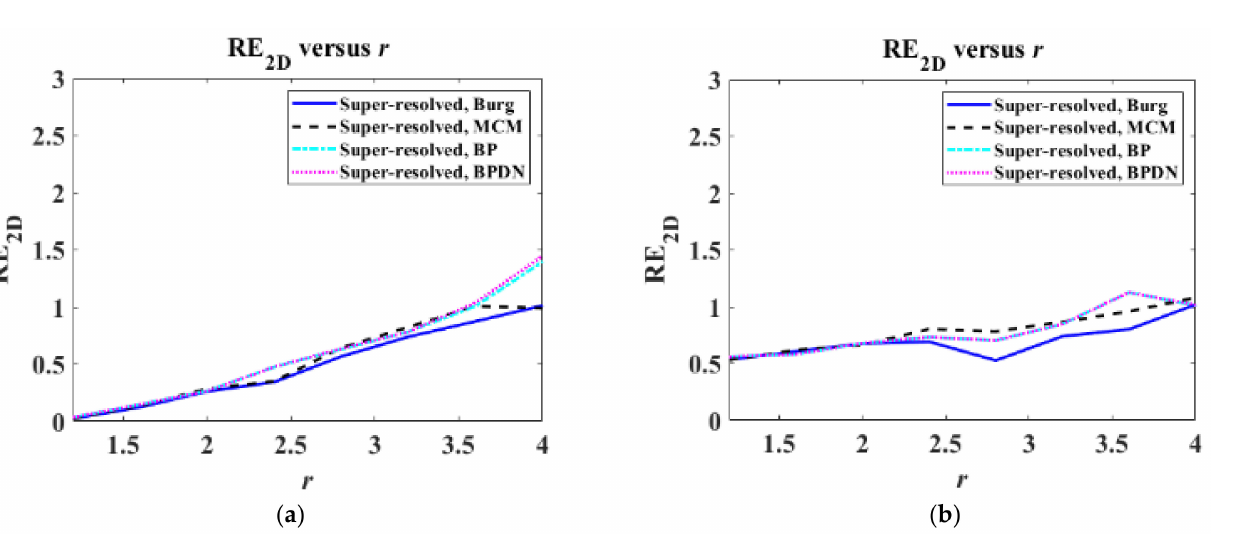
Figure 11. RE 2 D versus r for target images of extended targets: ( a ) static target and ( b ) moving